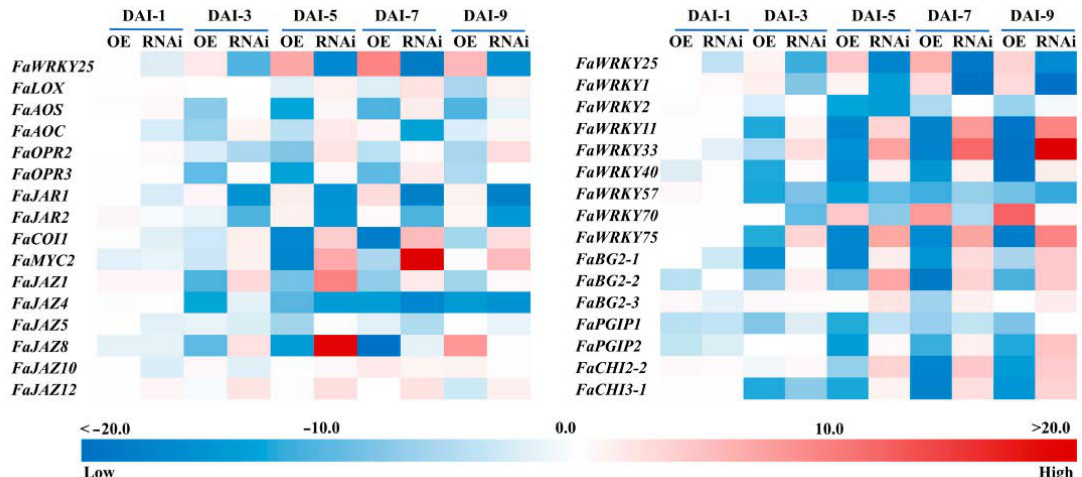
Figure 4. Effects of FaWRKY25 -OE and -RNAi on transcription of resistance-related genes. OE and RNAi denote overex- pression and silencing expression of the FaWRKY25 gene. With the wild strawberries without bacterial injection as the control group, the relative gene expression in the empty vectors (EV-OE or EV-As), FaWRKY25 -OE, and FaWRKY25 -RNAi groups was calculated. The expression in the FaWRKY25 -OE and FaWRKY25 -RNAi groups was than divided by that in the empty vector group, and the results were used to create a heat map.